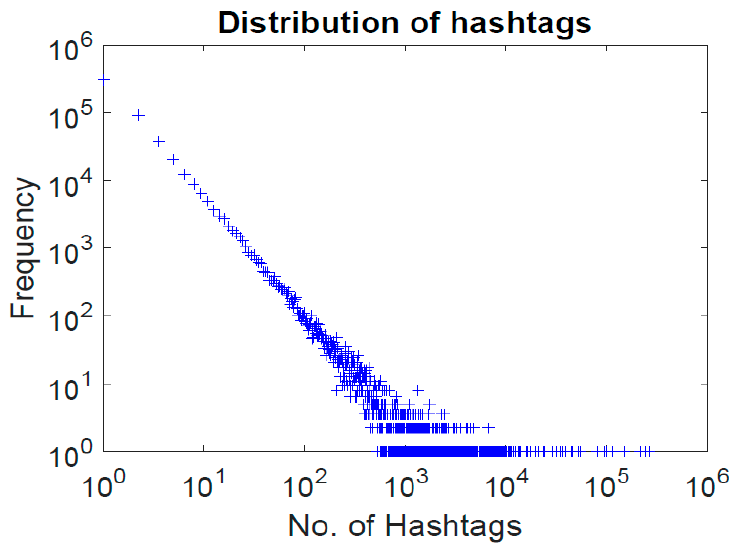
Figure 6. Hashtags Figure 6. Hashtags distribution.